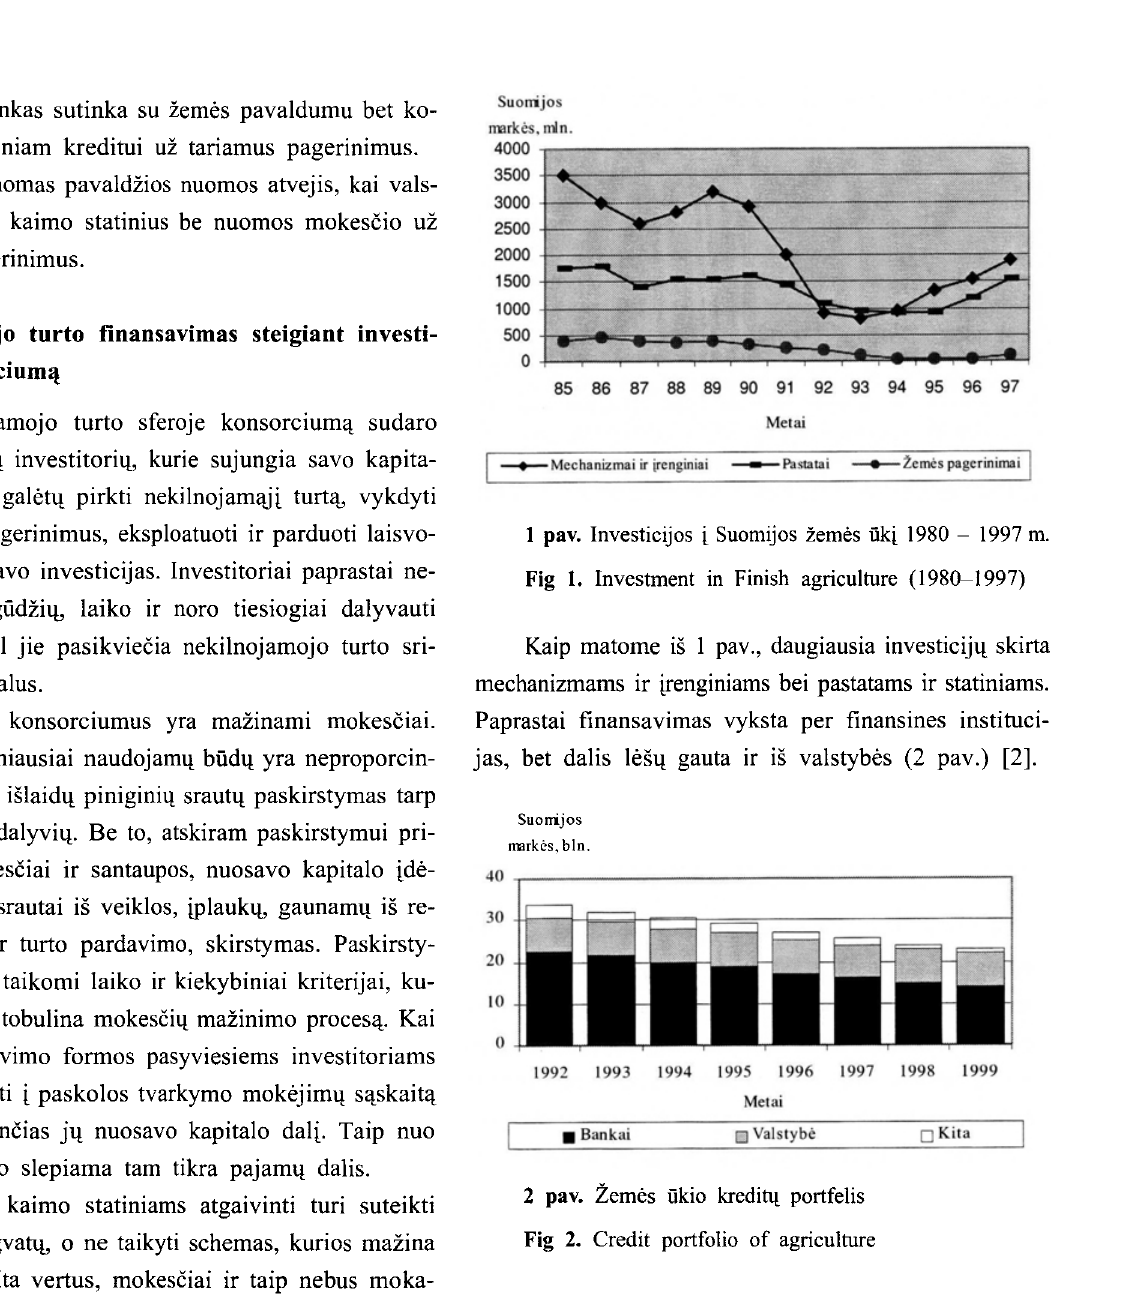
Fig 2. Credit portfolio of